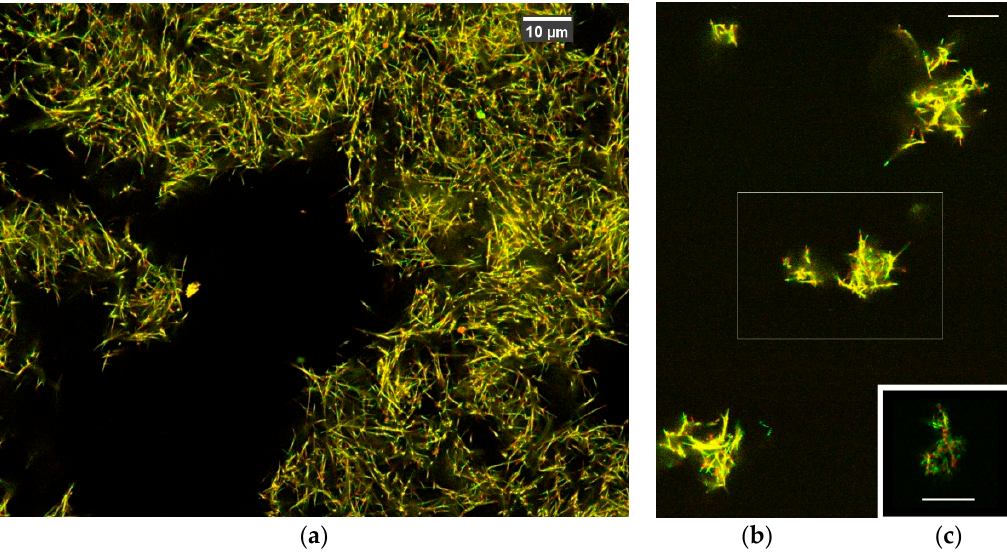
Figure 1. Imaging results of the network structure of microtubules in an artificial muscle specimen, by confocal laser scanning microscopy (CLSM): ( a ) the microtubule concentration at 10 µ M, ( b ) the concentration at 0.1 µ M. The inset box in ( b ) was used for the 3D volume data construction in this study, and ( c ) an assembly of microtubules without kinesin linkers. Microtubule filaments labeled with Alexa488 dye visible in green color, while the DNA origami binding region is labeled with TAMRA dye and is visible in red color. Most filament bodies of microtubules bind both dyes and present a yellow appearance. Scale bars, 10 μ m.